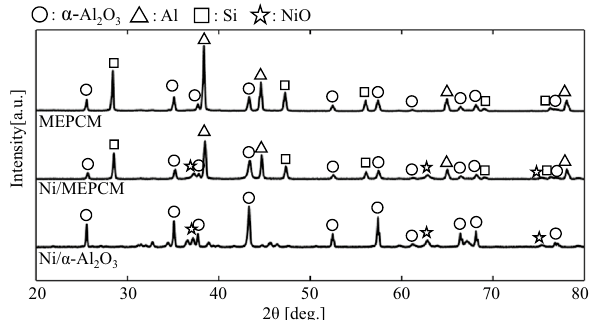
Figure 4. X-ray diffraction (XRD) patterns of the MEPCM, Ni/MEPCM, and Ni/α-Al 2 O 3 .